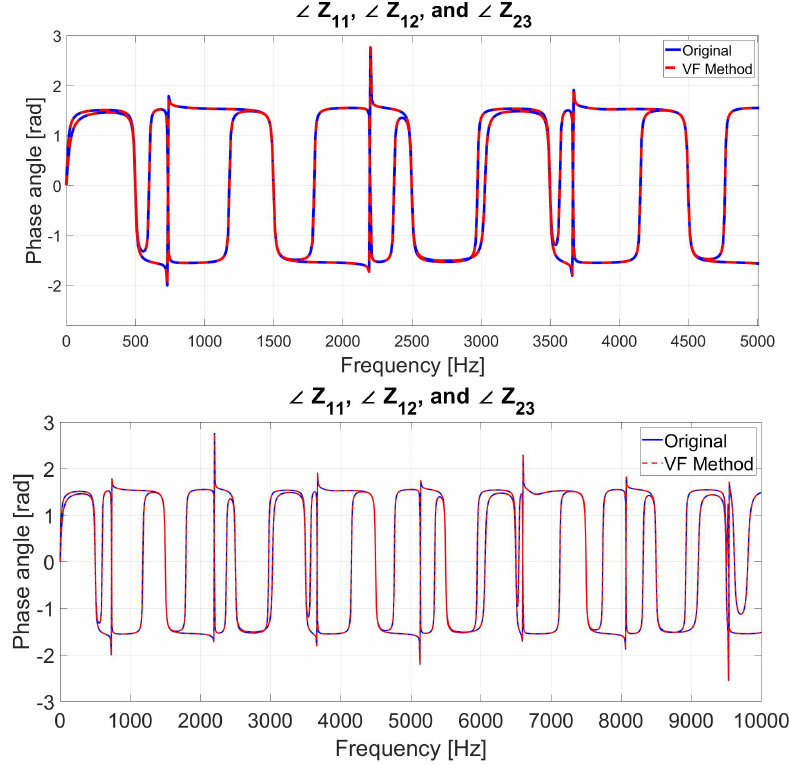
Figure 20. The angle of the measured and fitted impedance using VF , ∠ Z 11 , ∠ Z 12 , and ∠ Z 23